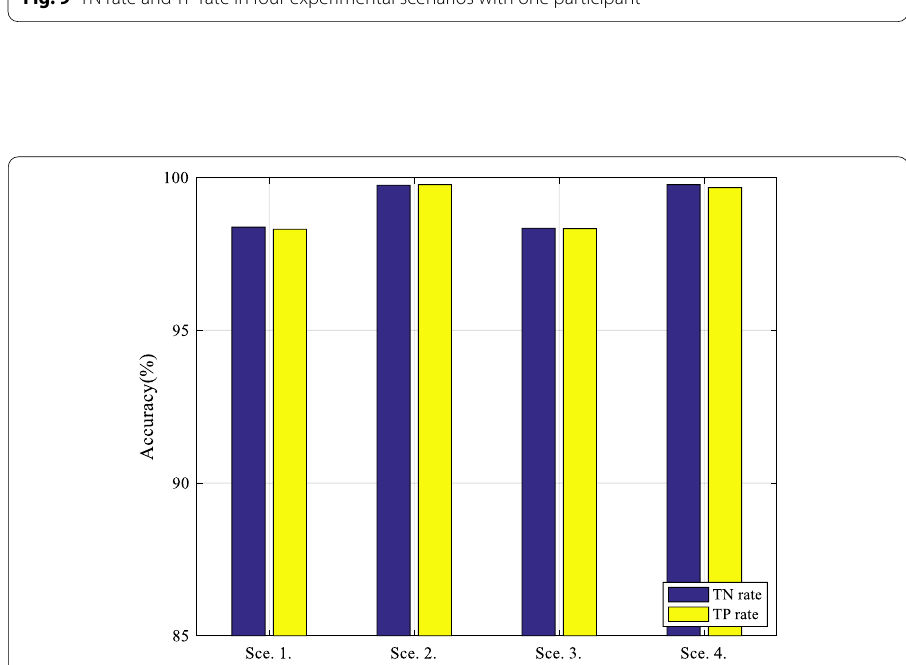
Fig. 10 TN rate and TP rate in four experimental scenarios with multiple